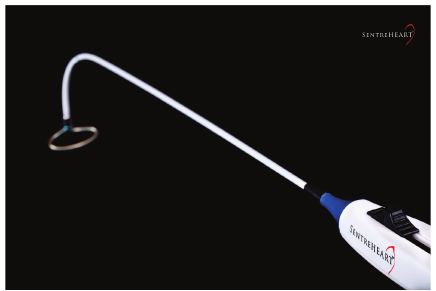
Figure 5: LARIAT (Image courtesy of